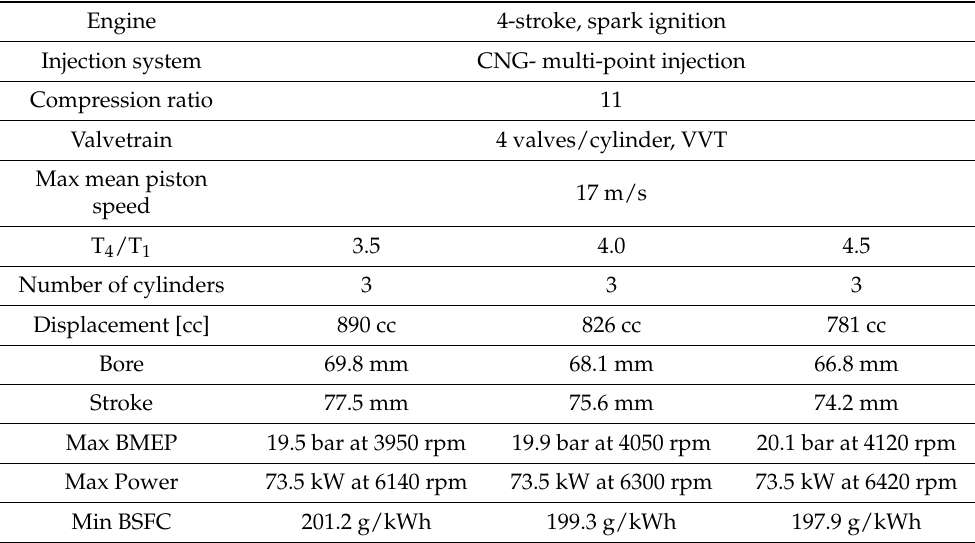
Table 4. Main characteristics of the reference turbocharged engine evaluated for each of the three temperature ratios T 4 /T 1